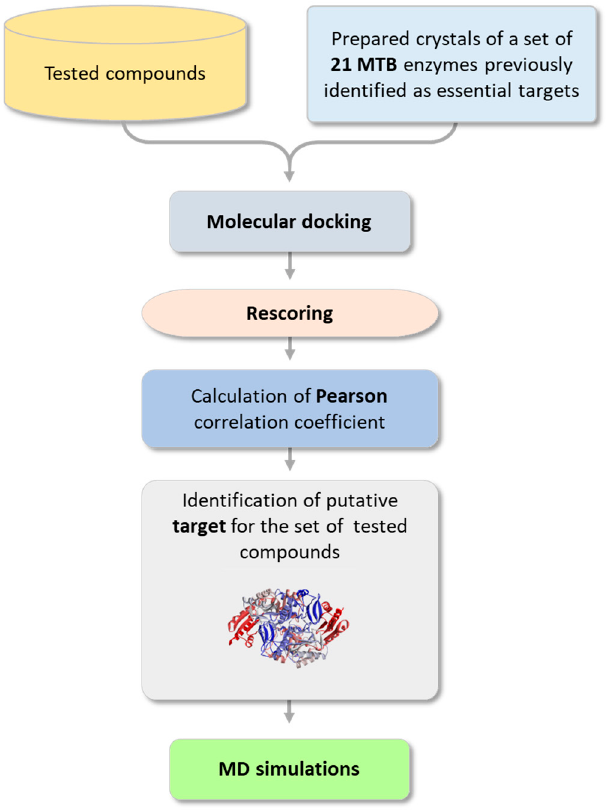
Figure 5. Summary of the computational workflow implemented in this study.